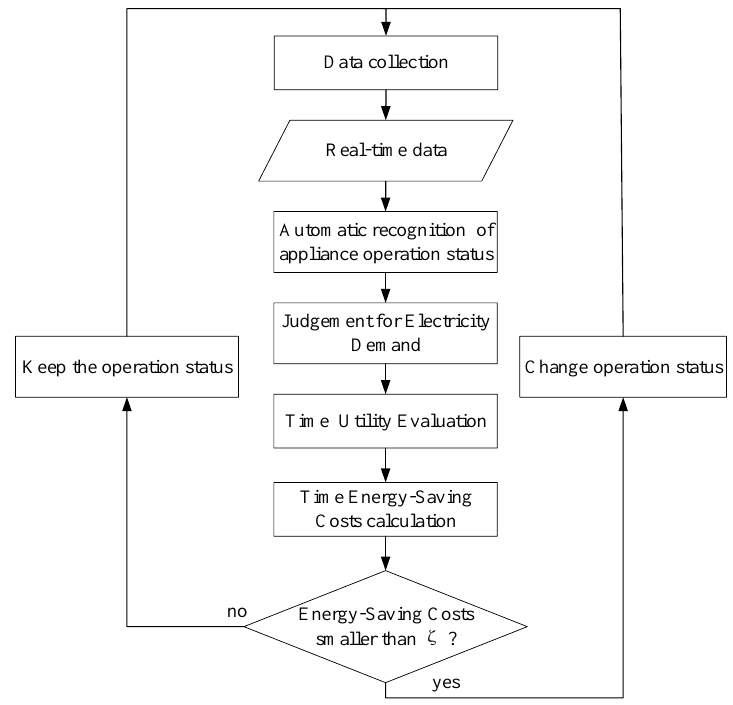
Figure 2. Energy saving optimization flow for time-sensitive appliances.